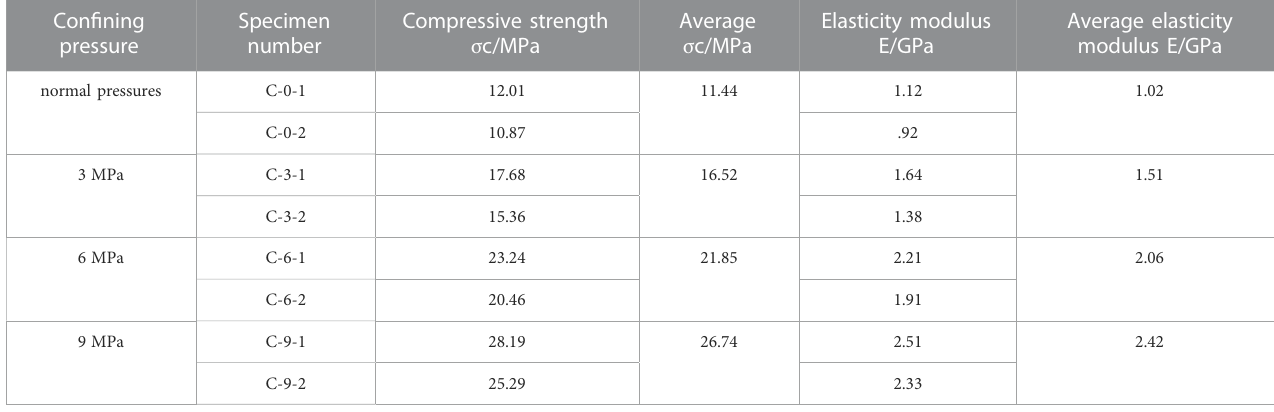
TABLE 1 Compression test results of coal specimens under different con fi ning pressures.